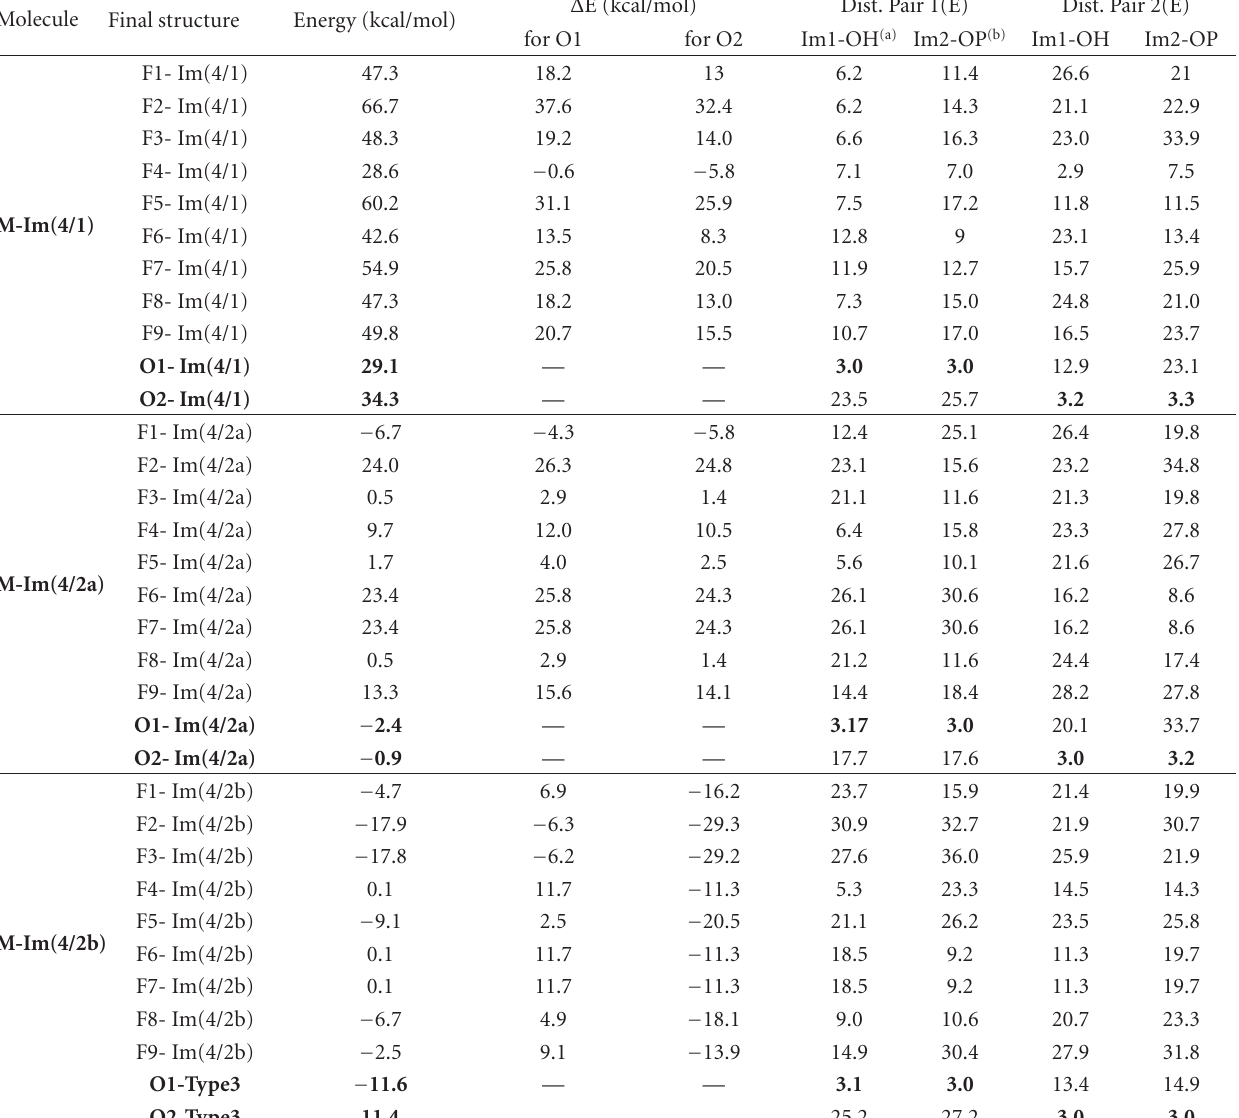
Table 2: Distances between active centers of the conjugates B-Im(4/m) and RNA target atoms. Molecule Final